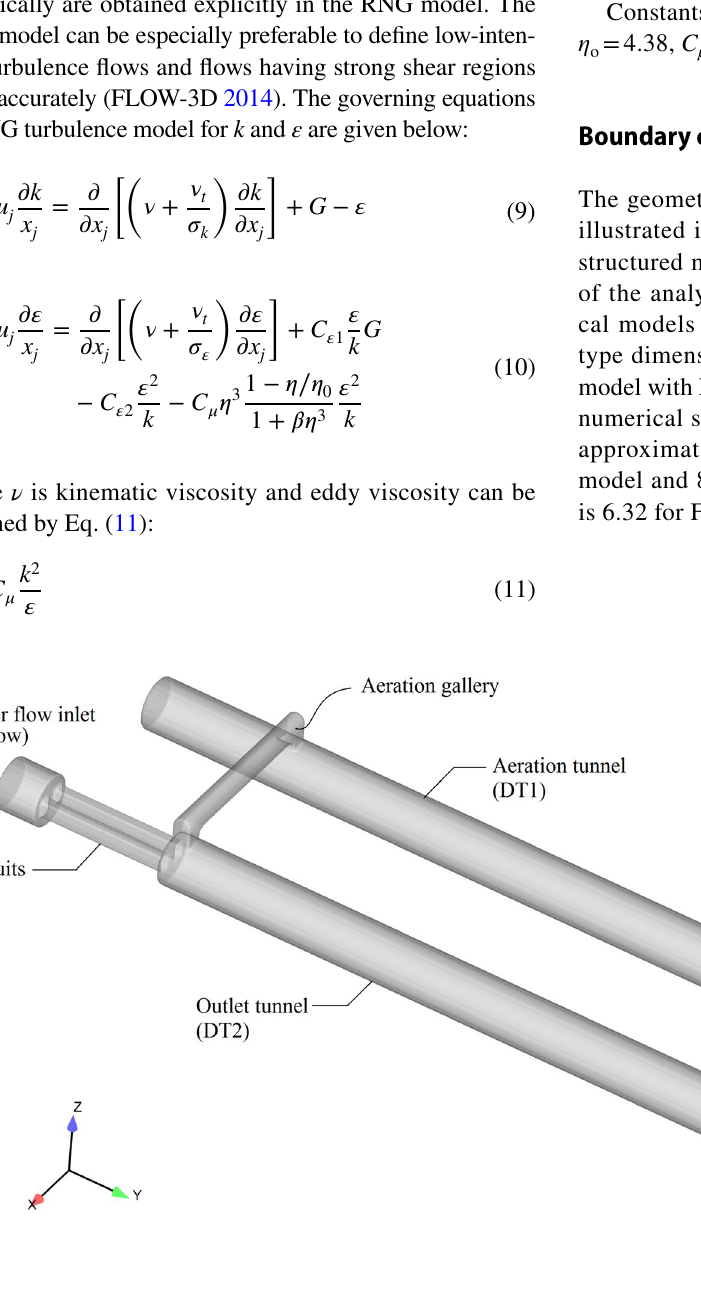
Fig. 2 CFD model geometry and boundary